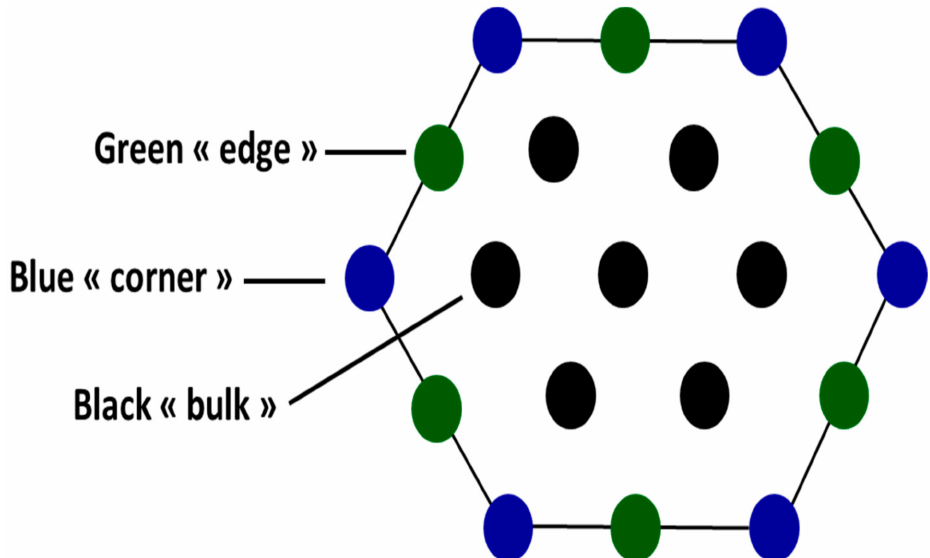
Figure 1. Schematic representation of a 2D hexagonal-shaped lattice comprising 19 molecules (H3). Filled black circles represent bulk sites (N b ), and filled green and blue circles represent, respectively, the edge (N e ) and corner (N c ) sites that interact with their immediate environment (matrix).